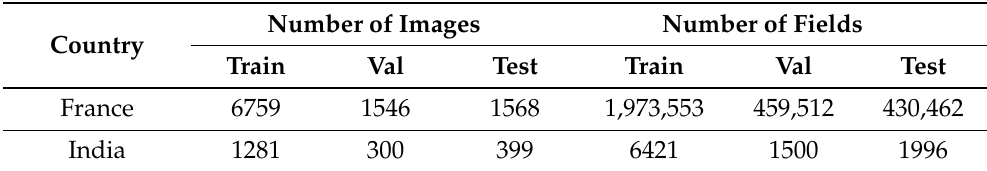
Table 1. Number of images and fields in each split of the France and India datasets. Training, validation, and test sets were split in geographic blocks, with the split being around 64%-16%-20%